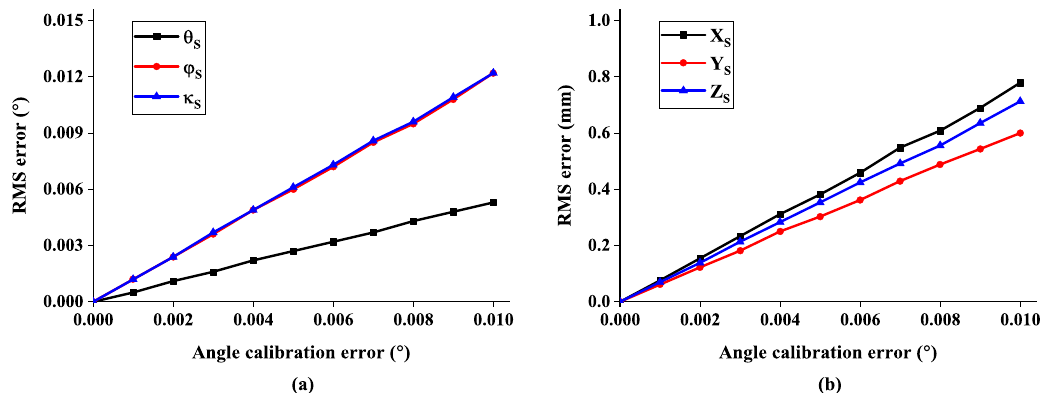
Figure 11. The RMS error of 6-DOF with respect to angle calibration error: ( a ) the error of rotation angle and ( b ) the error of system position.